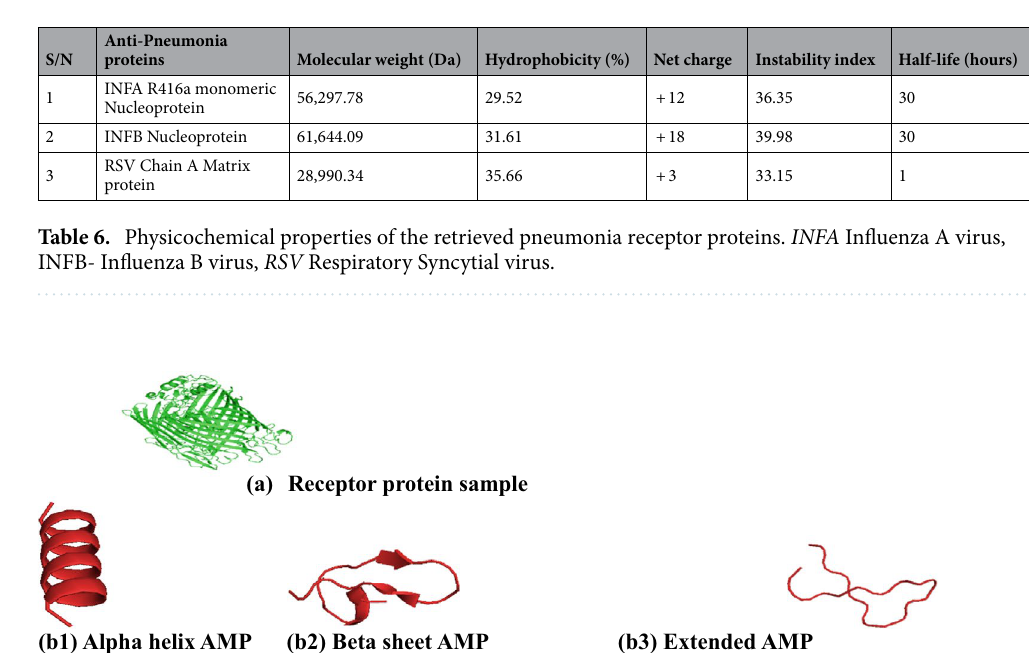
Figure 1. 3-D structures of the AMPs and pneumonia protein as determined by I-TASSER (https:// zhang group. org/I- TASSER/) 29 and visualized using PyMOL version 1.3 30 . 3D Structure of ( a ) Respiratory syncytial virus X fusion core protein ( b1 ) alpha-helical AMP, ( b2 ) beta-sheet AMP, ( b3 ) extended sheet